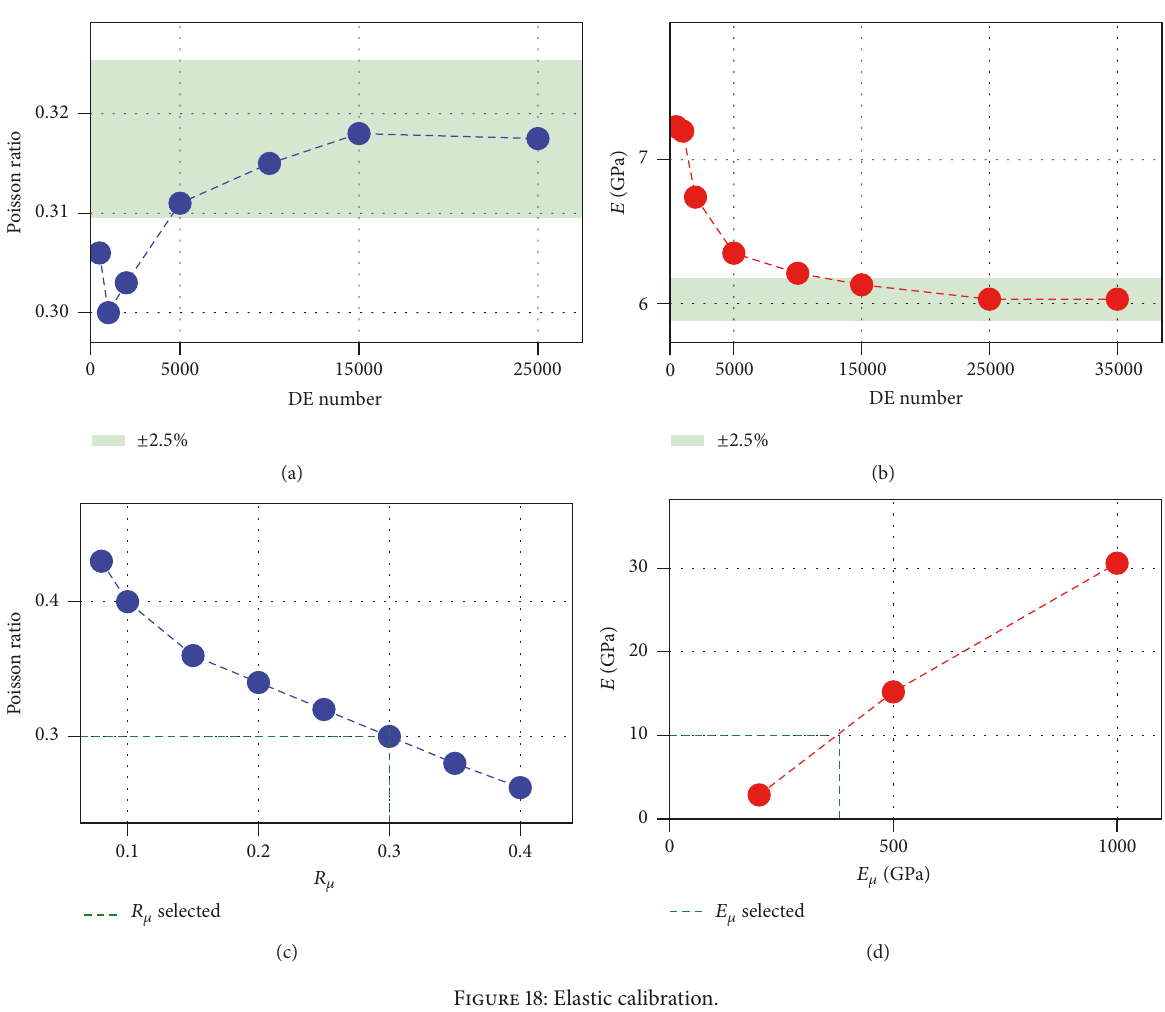
Figure 18: Elastic calibration.